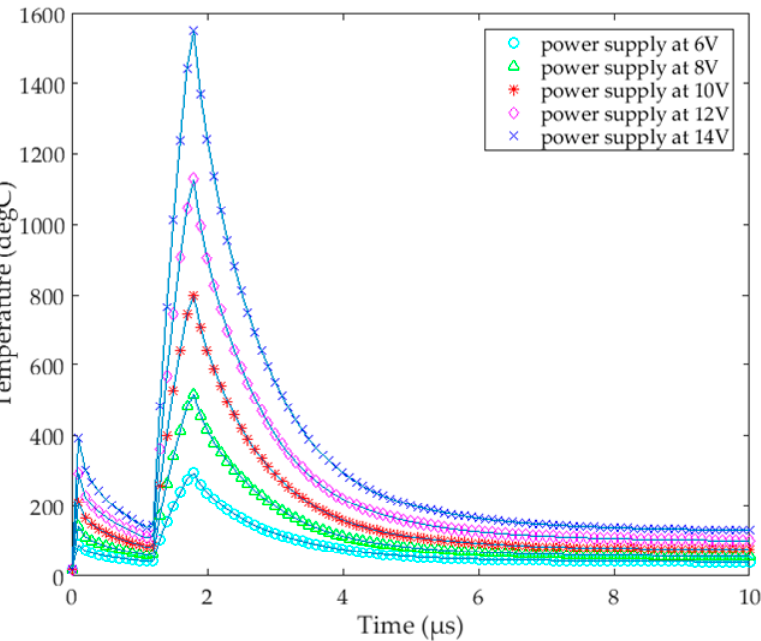
Figure 5. The temperature changes of the selected key point at different times at the different driving voltages.